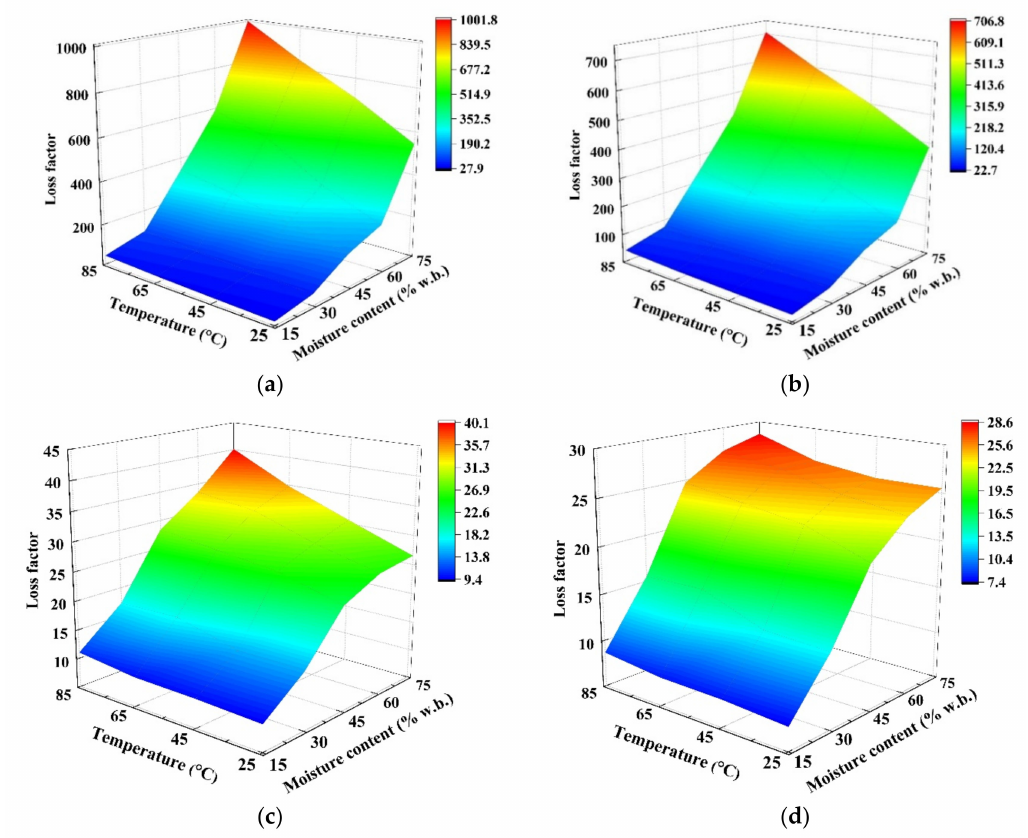
Figure 5. Moisture- and temperature-dependent dielectric loss factor ( ε ”) of wolfberries at 27 ( a ), 40 ( b ), 915 ( c ), and 2450 MHz ( d